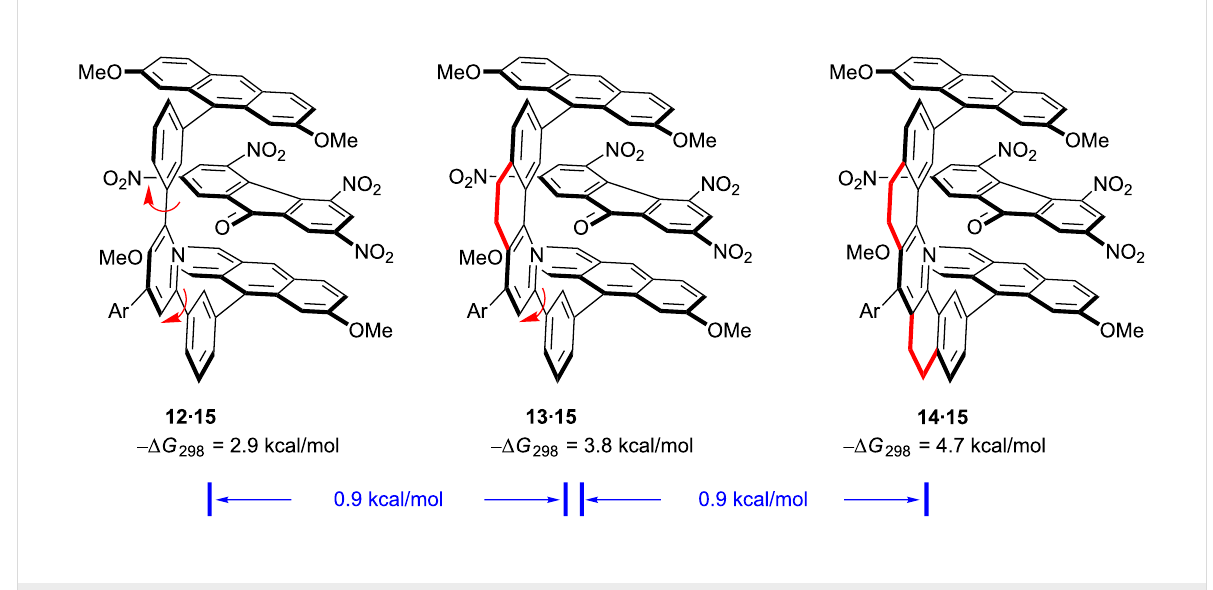
Figure 5: The first determination of the cost of freezing single bond rotations in a host–guest complex.